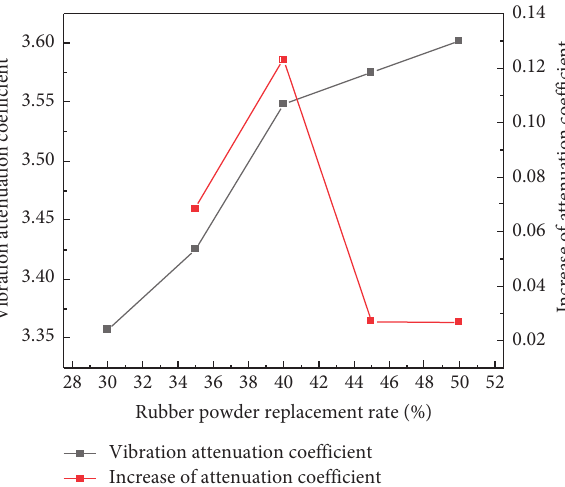
Figure 8: Effect of rubber powder replacement rate on vibration characteristics of tire/test piece Table 6: Vibration attenuation coefficient of cement concrete and emulsified asphalt mixture with different rubber particle contents [25]. Concrete type